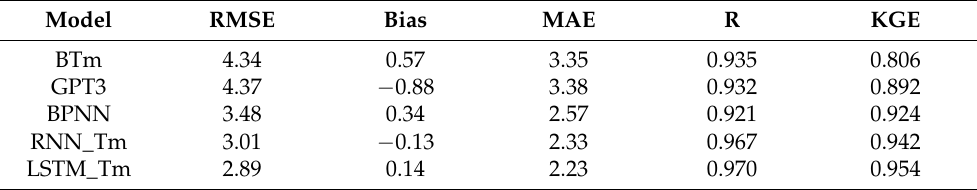
Table 3. Performance evaluation index of different